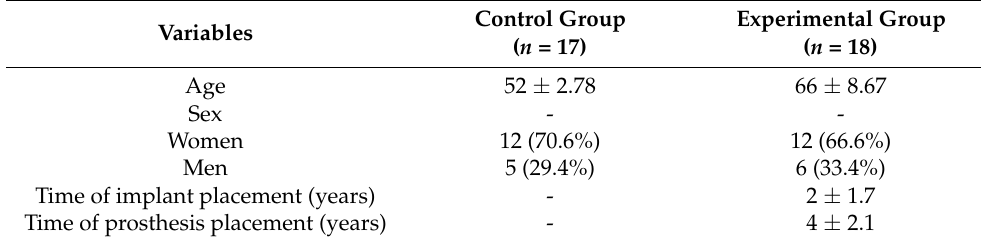
Table 1. Variables related to the study groups.